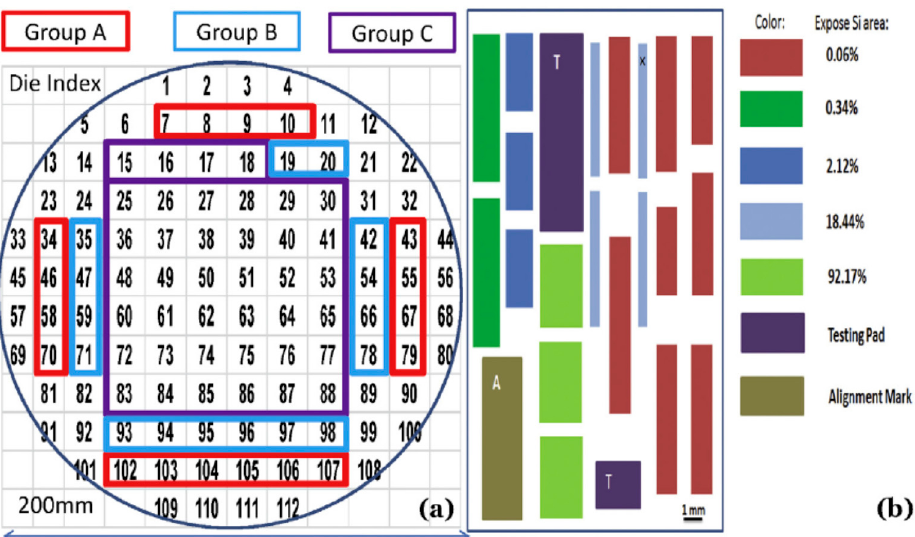
Figure 18. ( a ) The image of the processed chips on an 200 mm wafer where three groups were distinguished according to the transistor performance and ( b ) illustrates the pattern of one 112 manufactured chips where the different exposed Si areas are shown in different colors [94].